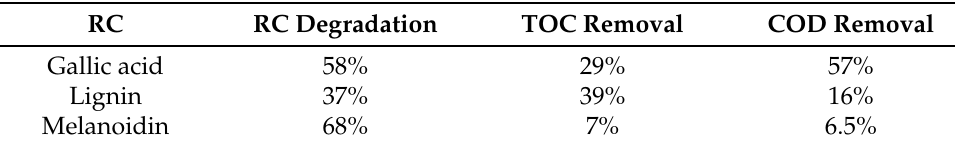
Table 5. Degradation of the studied RC under CL experimental